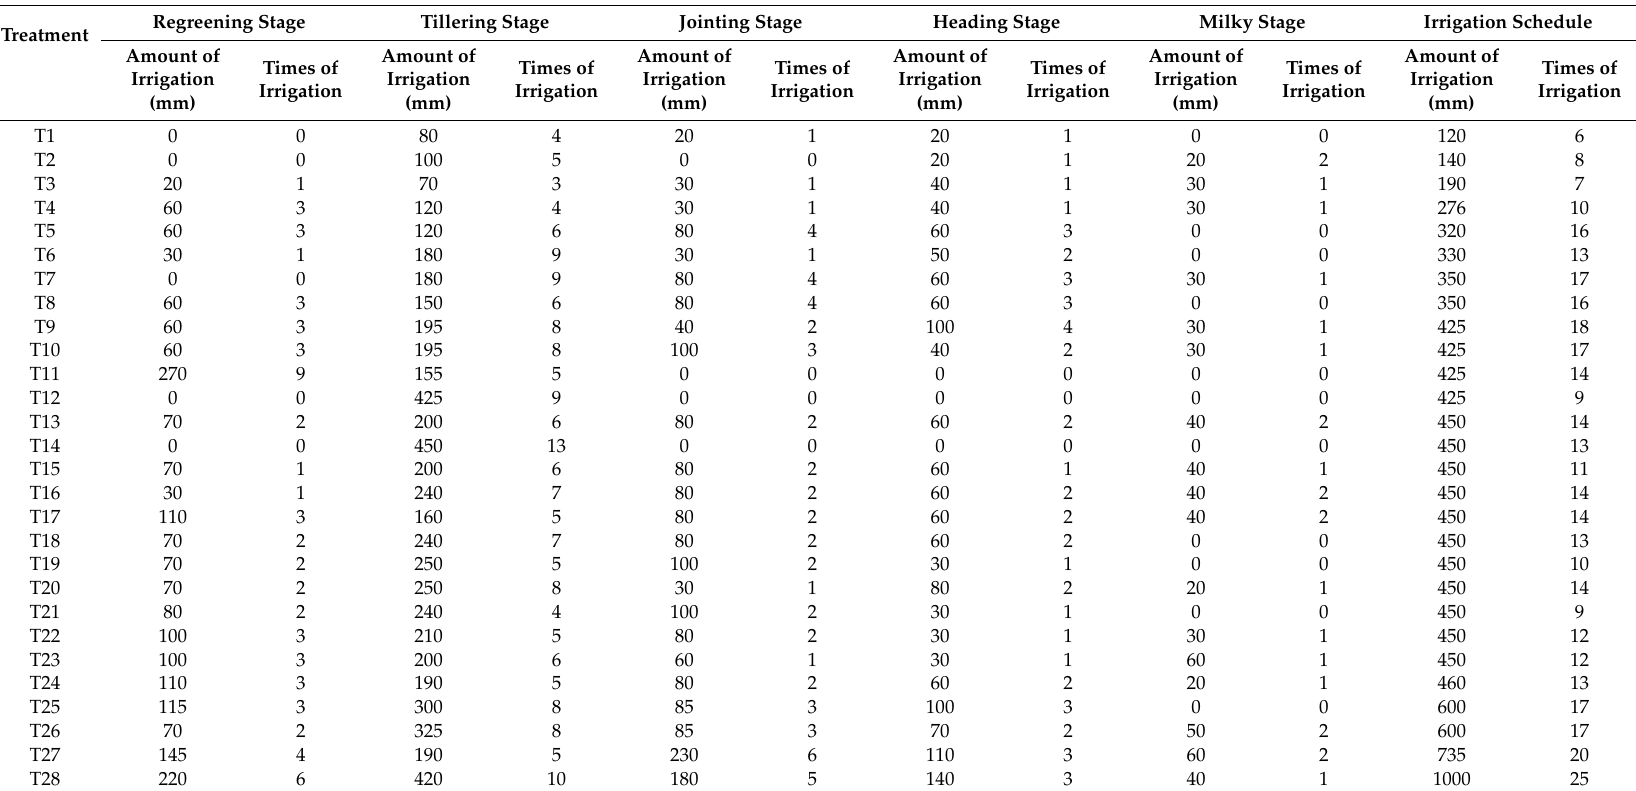
Table 1. Amount of irrigation and times ofiIrrigation under each